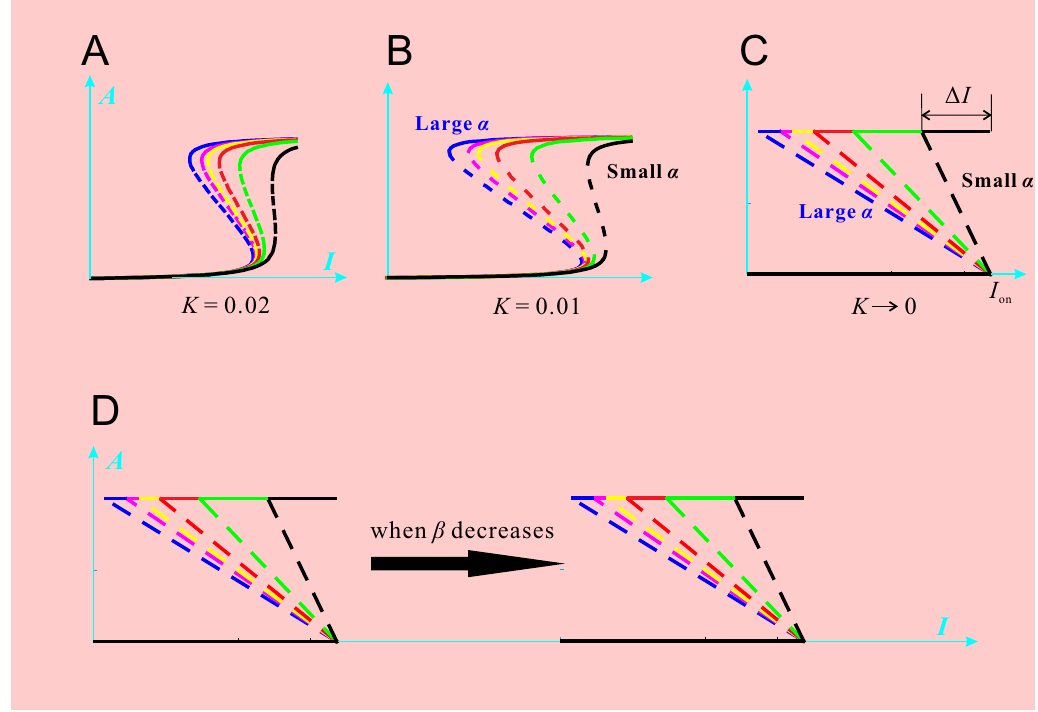
Figure 2. Response objects under various parameter conditions. The parameter α represents the feedback strength from pAkt to IRS. The parameter β corresponds to PI3K activity. The parameter K has the expression K m / [ Akt total ] , where K m is the Michaelis constant of Akt phosphorylation. ( A ) A family of response objects with the same K = 0.02 and β = 1 but with different α values. The blue (black) curve has large (small) α value; ( B ) The same family of response objects with K = 0.01 and β = 1; ( C ) The same family of response objects with K = 0 and β = 1; ( D ) The decrease of β causes right-shift of the response